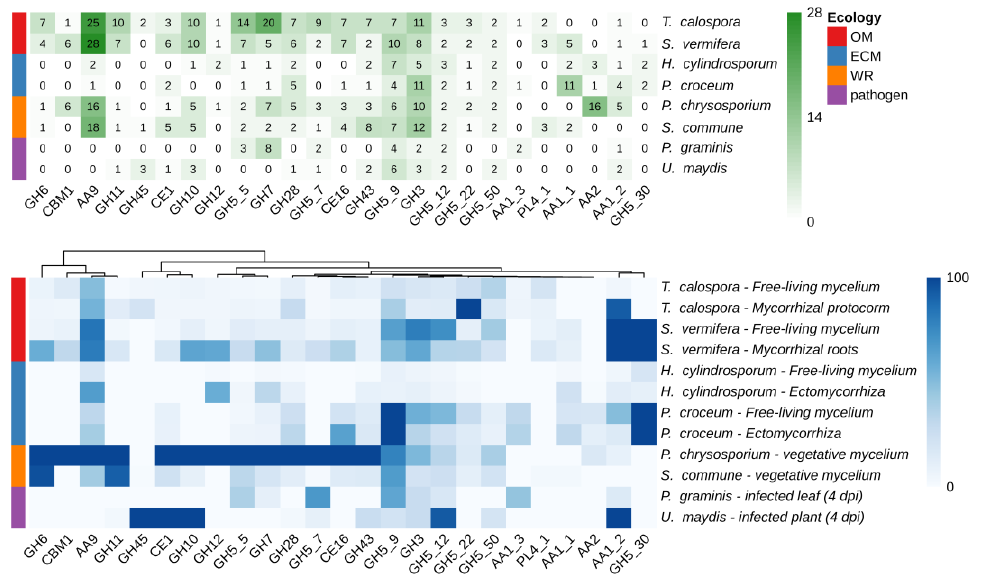
Figure 3. Number of CAZymes encoding-genes annotated in a number of Basidiomycota genomes (upper panel) and heatmap of expression levels across different tissues and conditions (bottom panel). Expression values are reported in TPM (transcripts per million) and columns are clustered by using Euclidean distances. Fungal species with different lifestyles were considered: orchid mycorrhizal (OM), ecto-mycorrhizal (ECM), white rot (WR), plant pathogens.